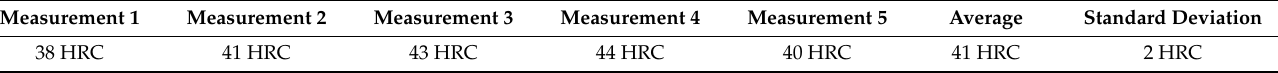
Table 2. Hardness measurements of the slipper-retainer.